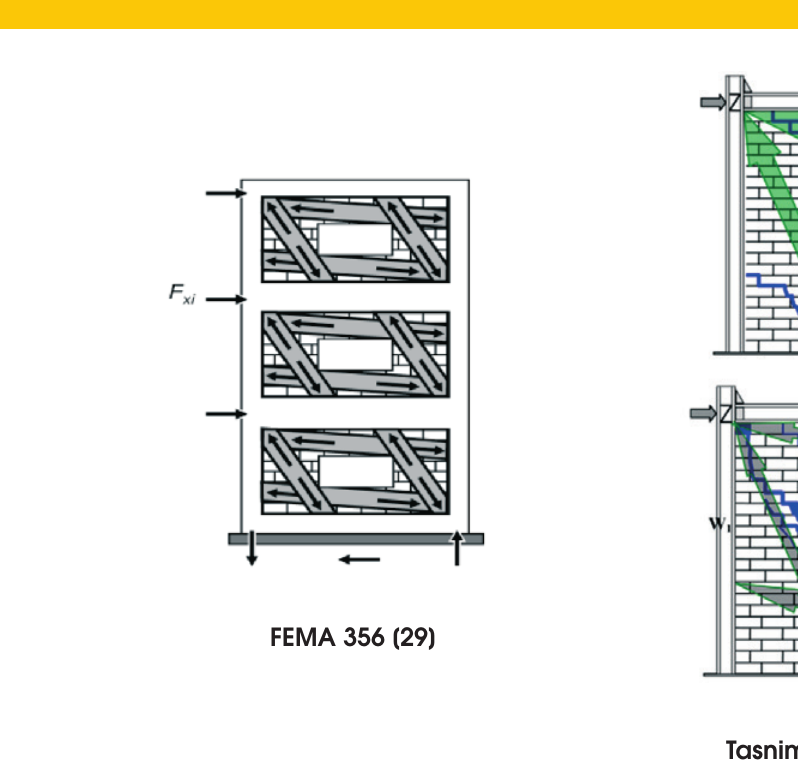
Figure 2 – Diagonal-Strut Models for masonry-infilled frames with